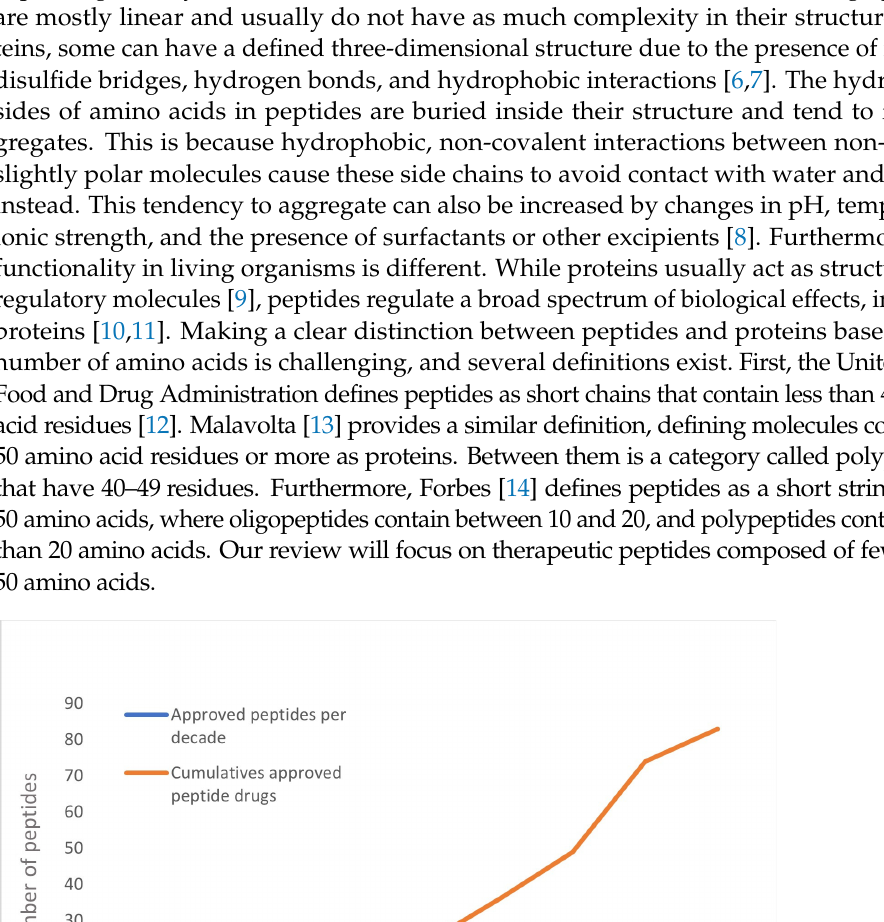
Table 1. Approved peptide drugs in the United States, Europe, and Japan from 2020.